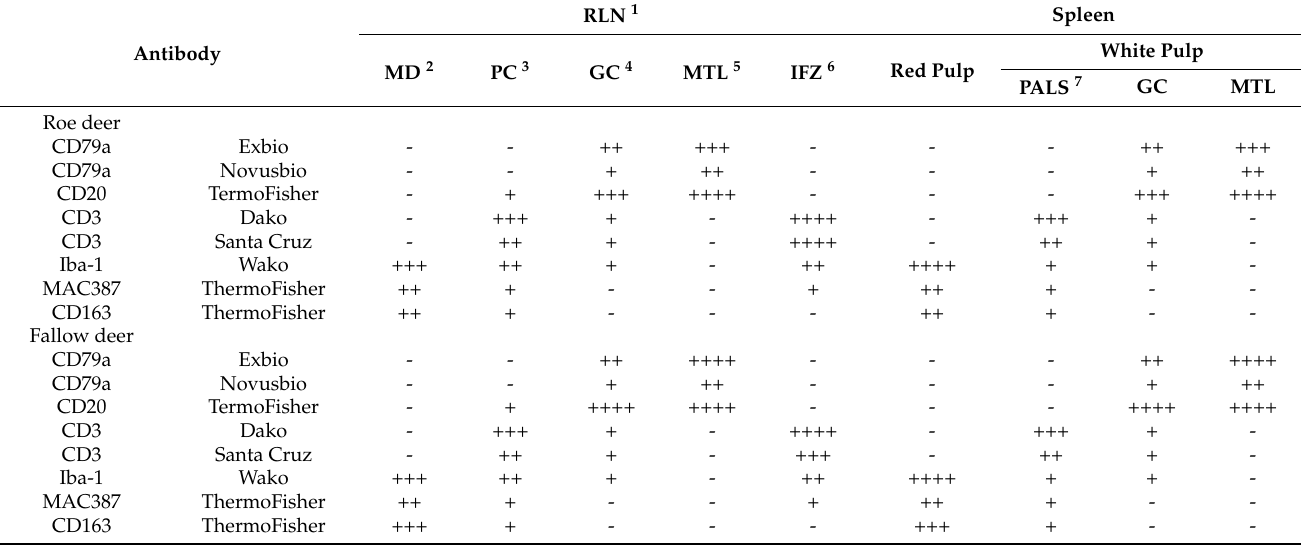
Table 2. Summary of the immunopositive cell distribution in different areas of the secondary lymphoid organs of the roe and fallow deer analyzed. Results expressed on the percentage of immunostained cells (-, absence; +, <10%; ++, 10–50%; +++, 50–90%; ++++, >90%). RLN